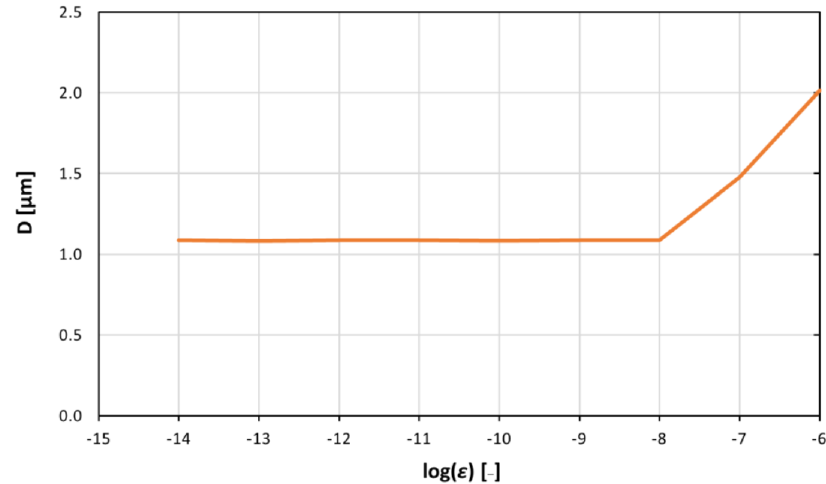
Figure 5. Average size of the agglomerates associated with different pair potential values between ε = 10 − 8 J and ε = 10 − 6 J at specific times (t = 12.5 s). Above the value of ε = 10 − 8 J, agglomeration starts, and the size of the agglomerates increases linearly with log( ε ).